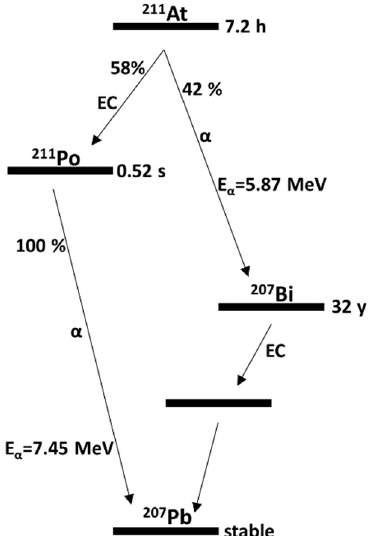
Figure 1. Decay scheme of 211 At (modified from Lindegren 2020)[9].